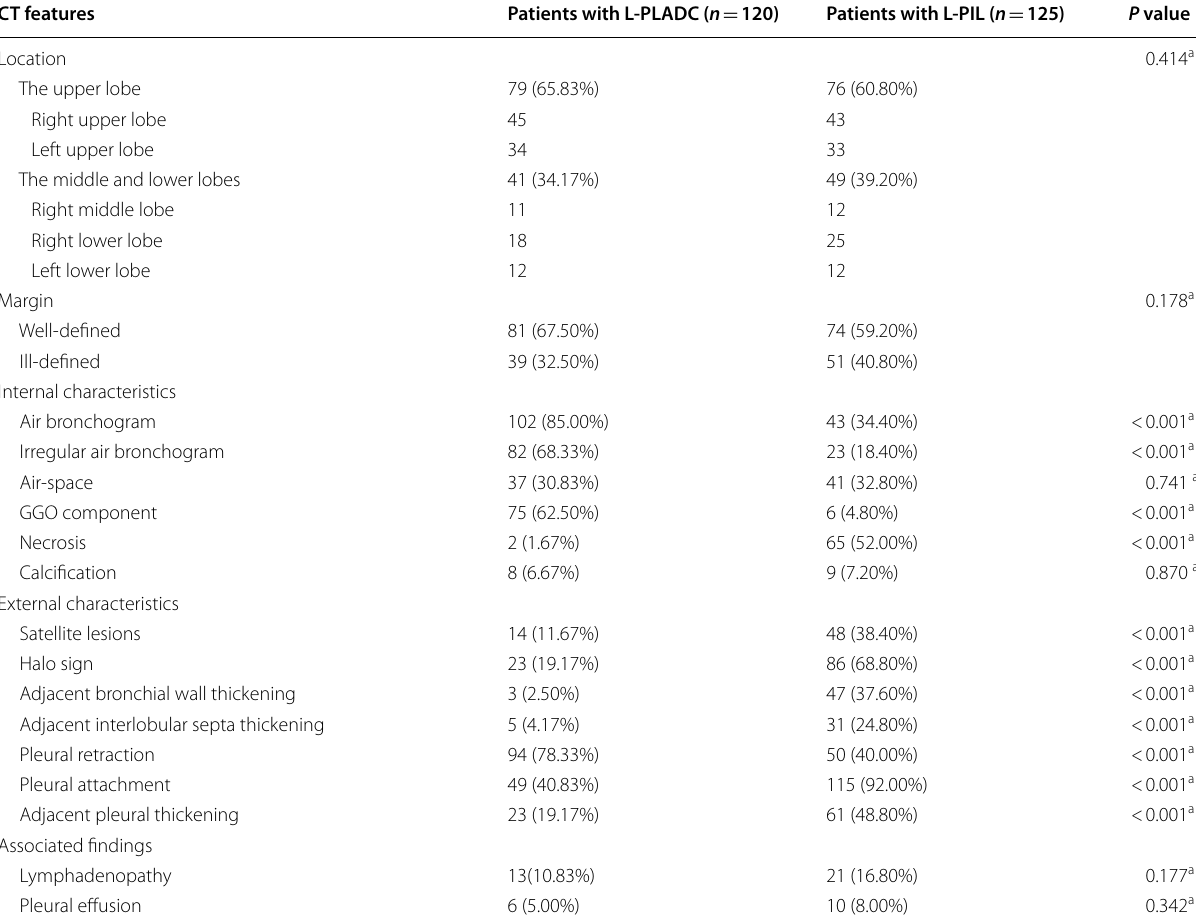
Table 2 Comparison of CT features between localized pneumonic‑type lung cancer and pulmonary inflammatory